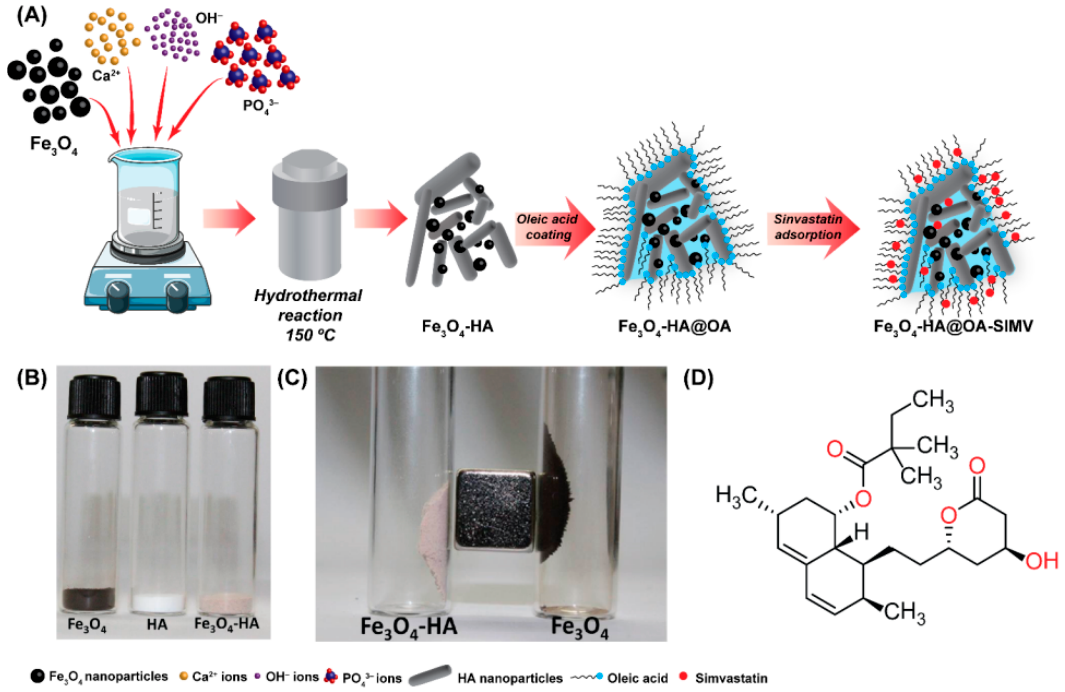
Figure 1. ( A ) Schemes for the synthesis of the nanomaterials prepared in this work. Macroscopic aspect of the samples Fe 3 O 4 , HA, and Fe 3 O 4 -HA ( B ) without and ( C ) under magnetic field. ( D ) Chemical structure of the Simvastatin.